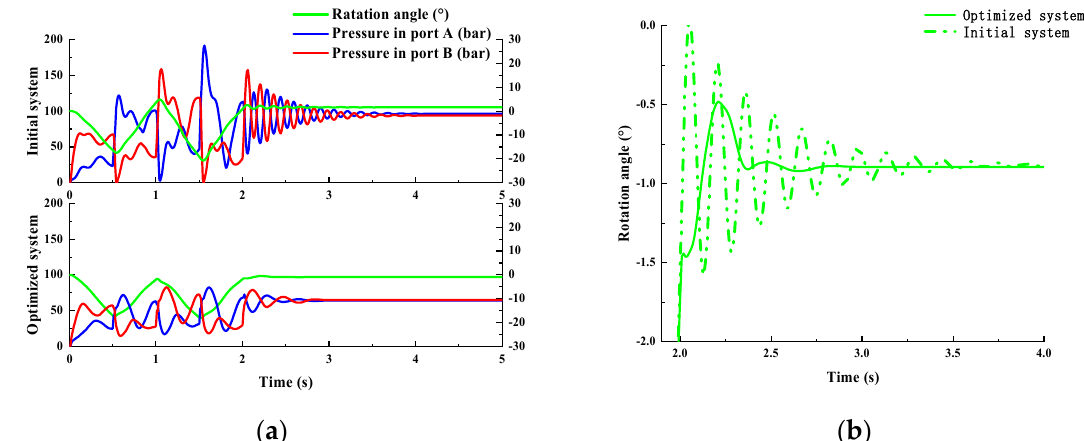
Figure 11. The swing steering wheel simulation result: ( a ) cylinder pressure and frame angle curve; ( b ) partial enlarged view of the steering angle. ( b ) partial enlarged view of the steering